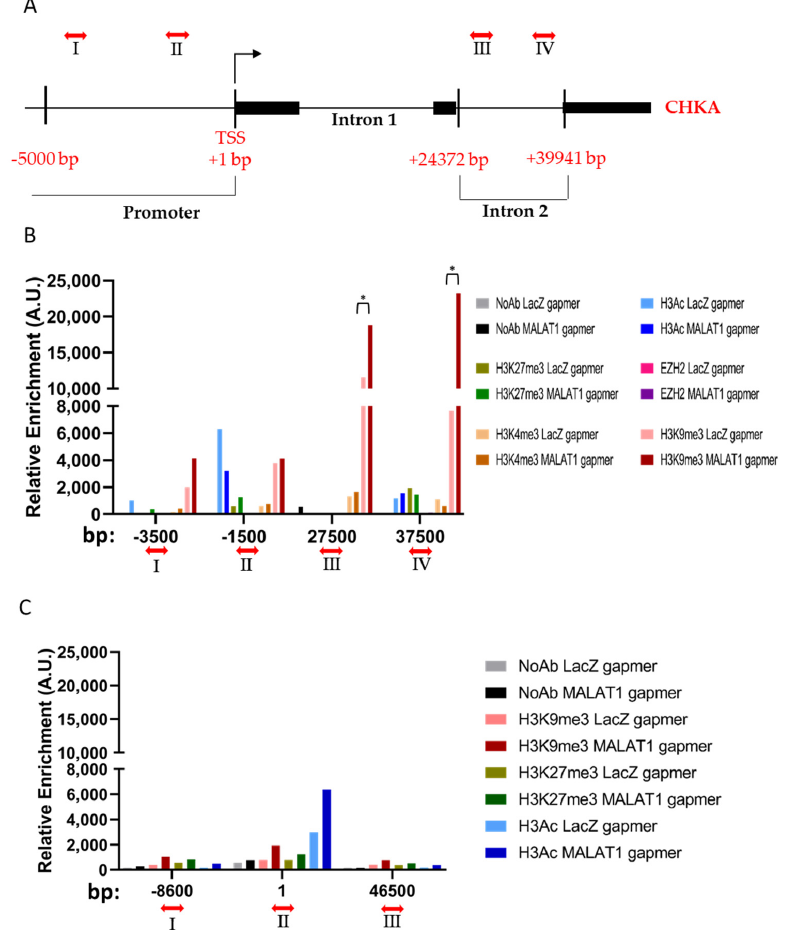
Figure 4. Chromatin remodeling in CHKA and Ceramide kinase (CERK) genes upon MALAT1 targeting: ( A ) Schematic diagram of CHKA genomic regions. Double-arrowed lines and roman numbers identify primer position among CHKA genomic regions; arabic numerals refer to the genomic positions in base pairs; black boxes refer to exons of the CHKA gene. ( B ) EZH2 chromatin binding and H3Ac, H3K27me3, H3K4me3, and H3K9me3 histone tail modifications on CHKA genome regions after MALAT1 gapmers transfection (16 h). ( C ) H3Ac, H3K27me3, and H3K9me3 histone tail modifications on CERK genome regions after MALAT1 gapmer transfection (16 h). No Antibody (NoAb) served as a negative control. Data are represented as relative enrichment in Arbitrary Units (AU). * p < 0.05 MALAT1gapmer vs.